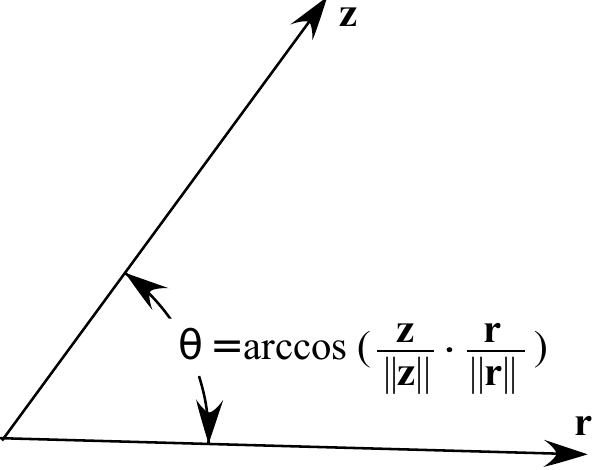
Figure 2. Geometric interpretation of the angle between two vectors using a dot